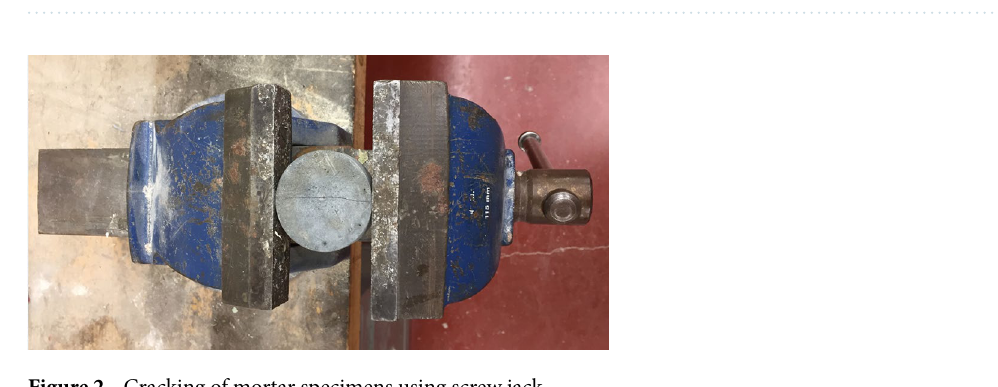
Figure 1. Cracking of mortar specimens using MTS machine.